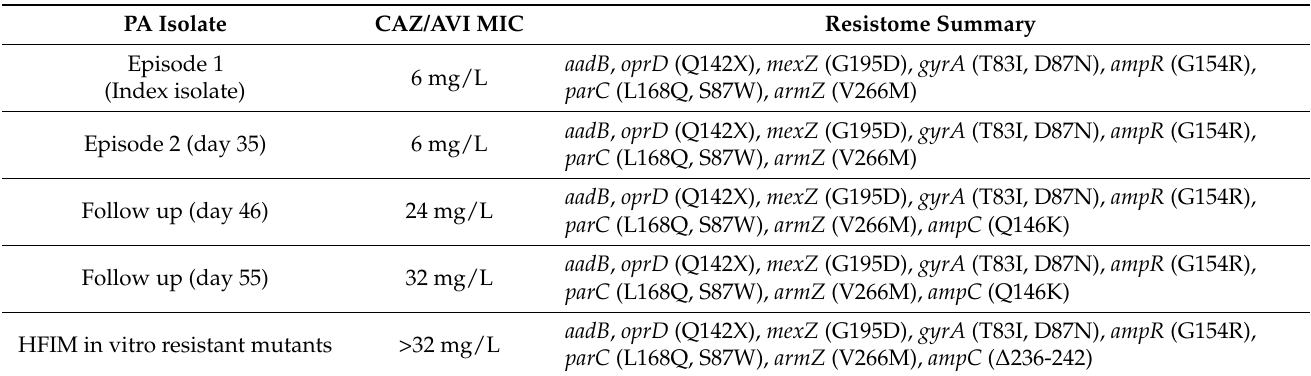
Table 1. Whole genome sequence resistome analysis of the studied P. aeruginosa clinical isolates and derived resistant mutants. PA, P. aeruginosa ; CAZ/AVI, ceftazidime/avibactam; MIC, minimum in- hibitory concentration; HFIM, hollow-fiber infection model.